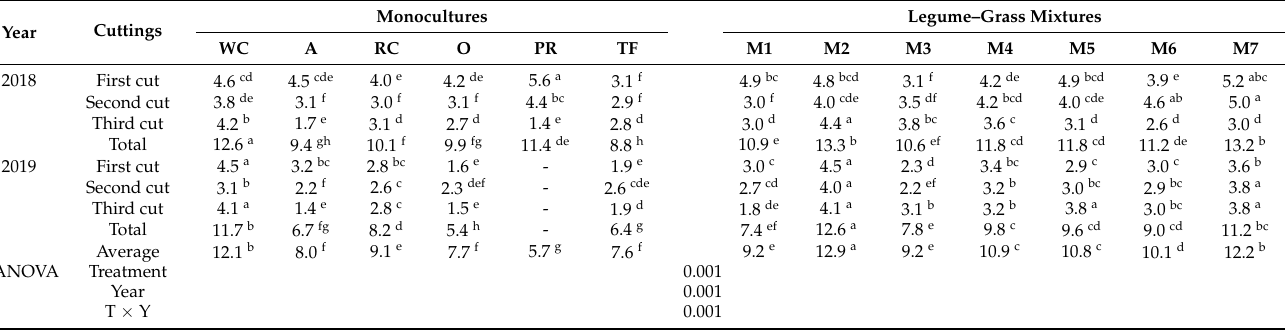
Table 4. The biomass yield (t ha − 1 ) of monocultures and their legume–grass mixtures in the estab- lishment years of 2018 and